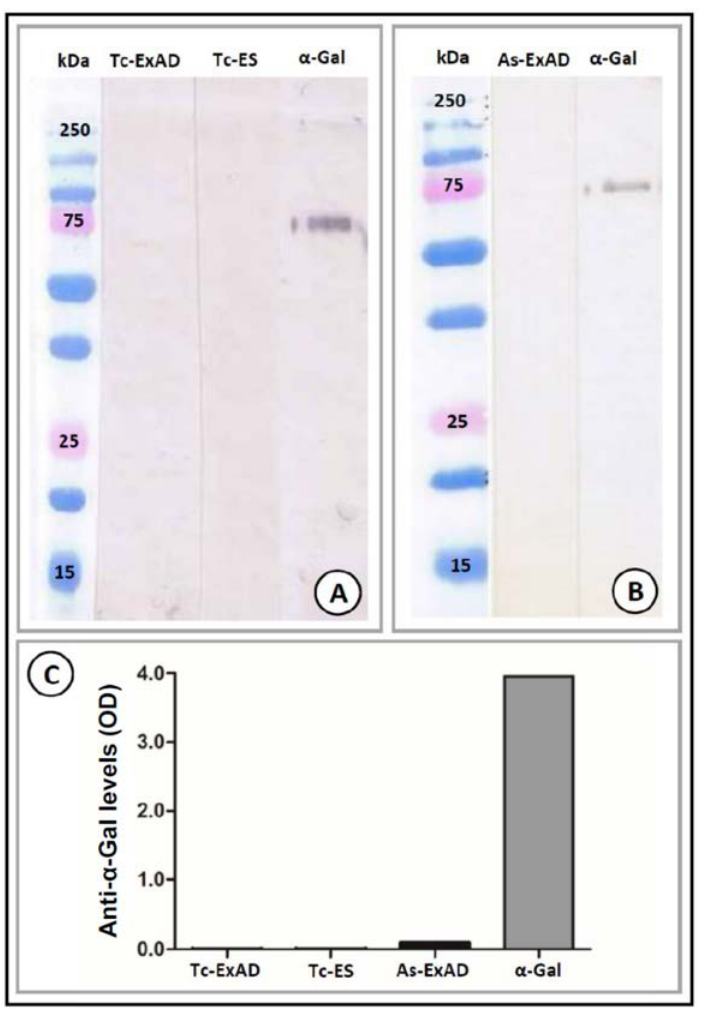
Figure 1. Detection of α -Gal on glycoproteins of Toxocara canis and Ascaris suum by Western blot ( A , B , respectively) and indirect ELISA ( C ). Disaccharide Galα1 -3Gal-HSA served as a positive control in both assays. The presence of α -Gal in the soluble proteins was assessed by a highly specific monoclonal anti- α -Gal antibody M86. Abbreviations: Tc-ExAD—crude extract of an adult female T. canis worm; Tc-ES—larval excretory/secretory antigens of T. canis (native antigen); As-ExAD—crude extract of an adult female A. suum worm; α -Gal— Galα1 -3Gal-HSA antigen; OD—optical density.